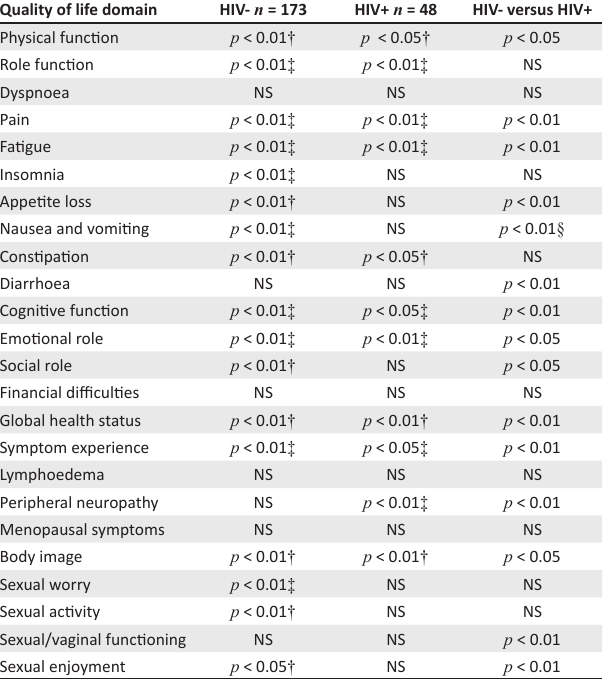
TABLE 2: Change in quality of life during study period.